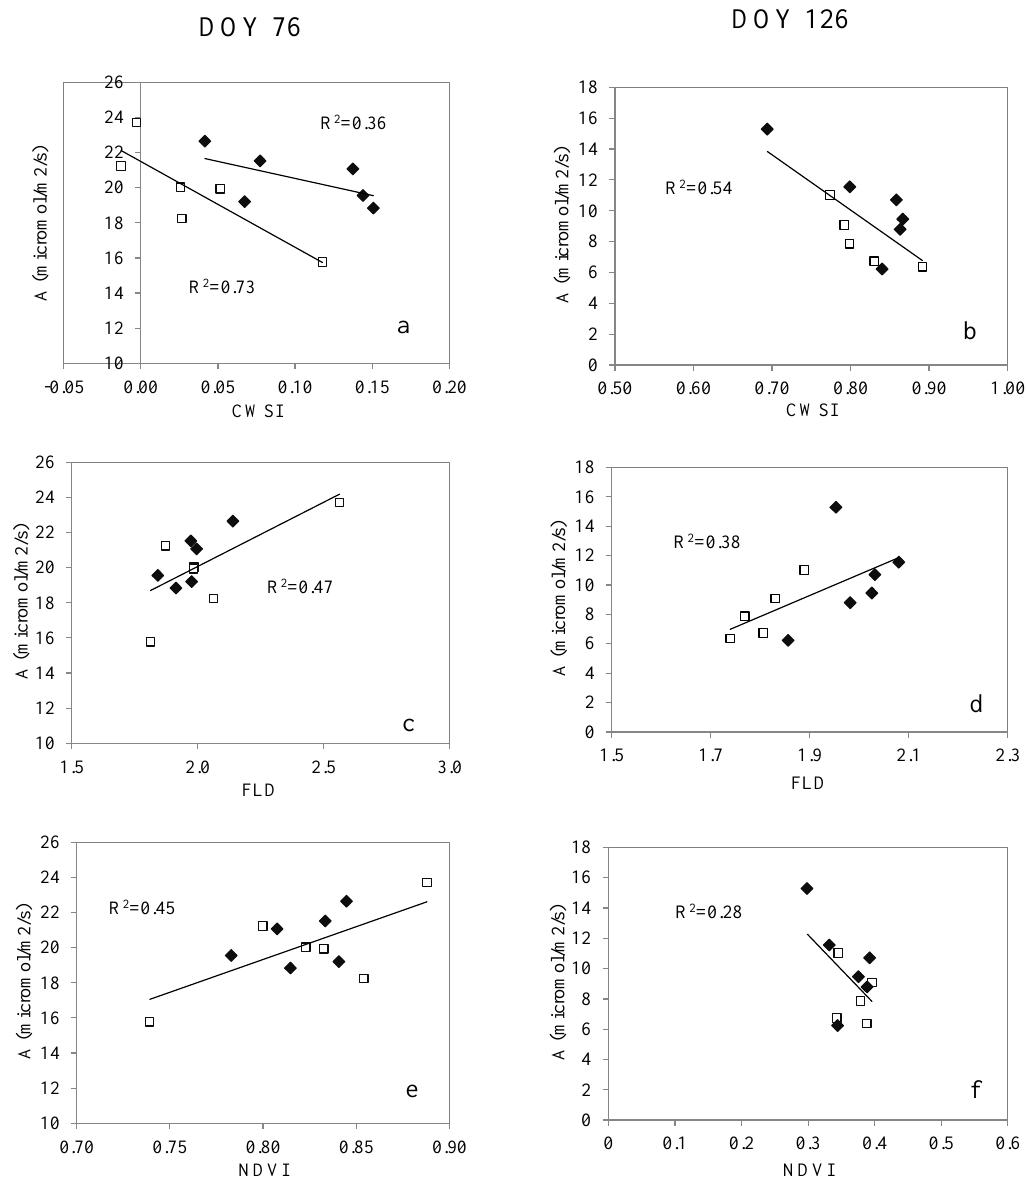
Figure 7. Relationship between net assimilation (A; μmol·m −2 ·s −1 ) and: CWSI ( a ) and ( b ), FLD ( c ) and ( d ) and NDVI ( e ) and ( f ) for two selected varieties of durum wheat (solid symbols) and two varieties of bread wheat (open symbols) on DOY 76 (a), (c) and (e) and DOY 126 (b), (d) and (f). For each case, a linear regression was